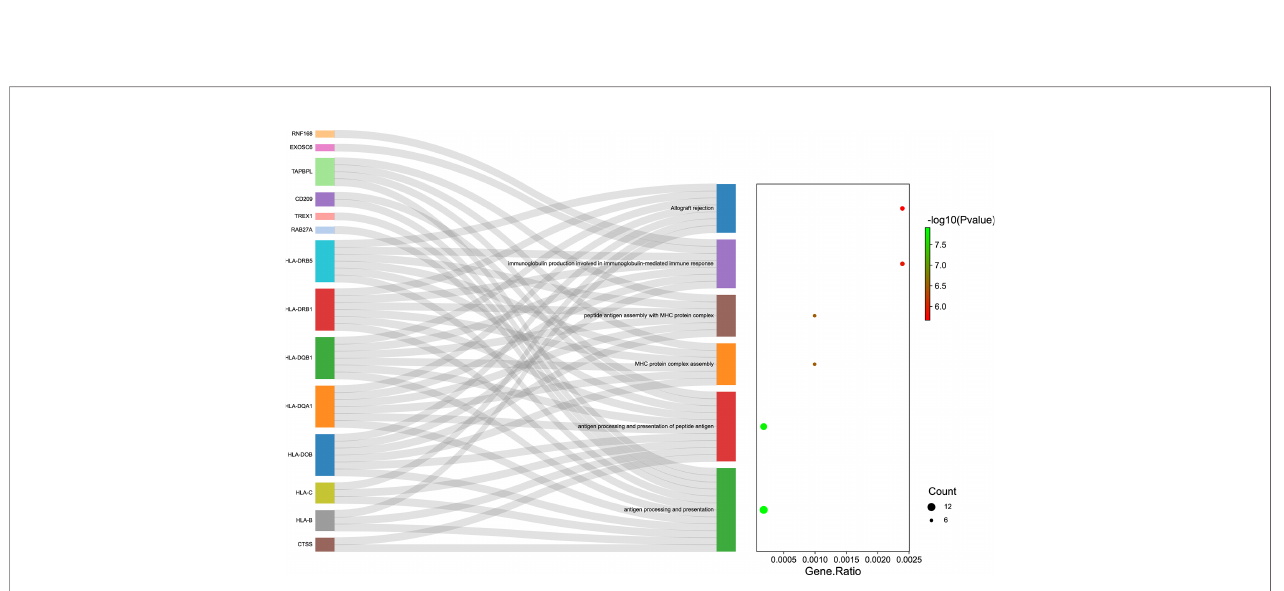
FIGURE 4 | The top overrepresented Gene Ontology (GO) terms and related genes. Sankey plot showed the relationship between the genes and overrepresented GO terms. The dot plot showed the ratio between the genes identi fi ed involved in GO terms and the total number of genes included in each GO terms (FDR P ≤ 0.05). GO, Gene